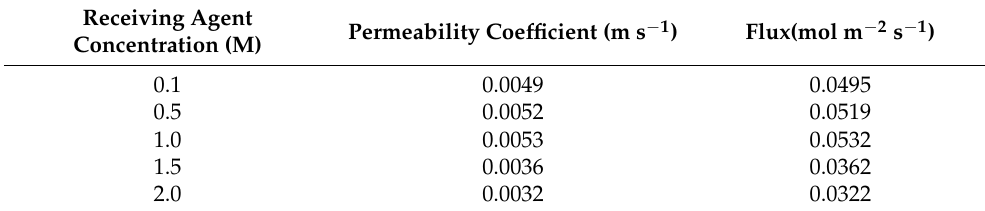
Table 10. The permeability and flux values for Zn 2+ removal by the W3 membrane at different receiving agent